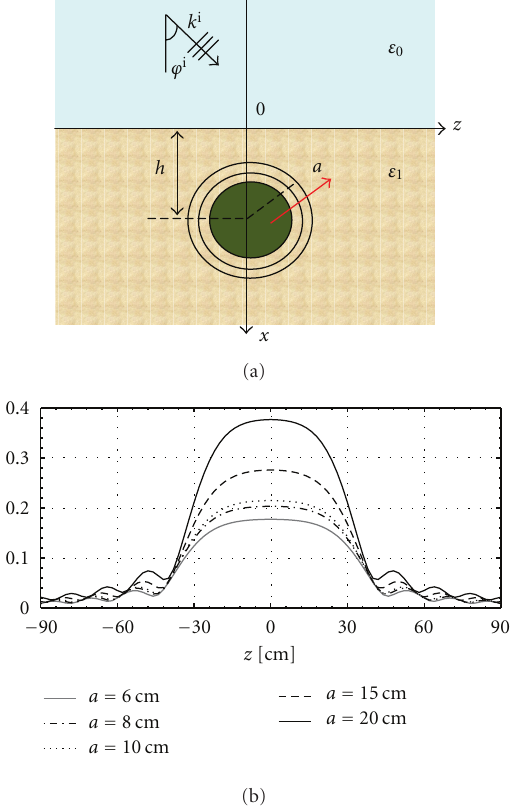
Figure 6: Total scattered field in air, along a line parallel to the interface, for di ff erent values of the radius of the metallic utility.